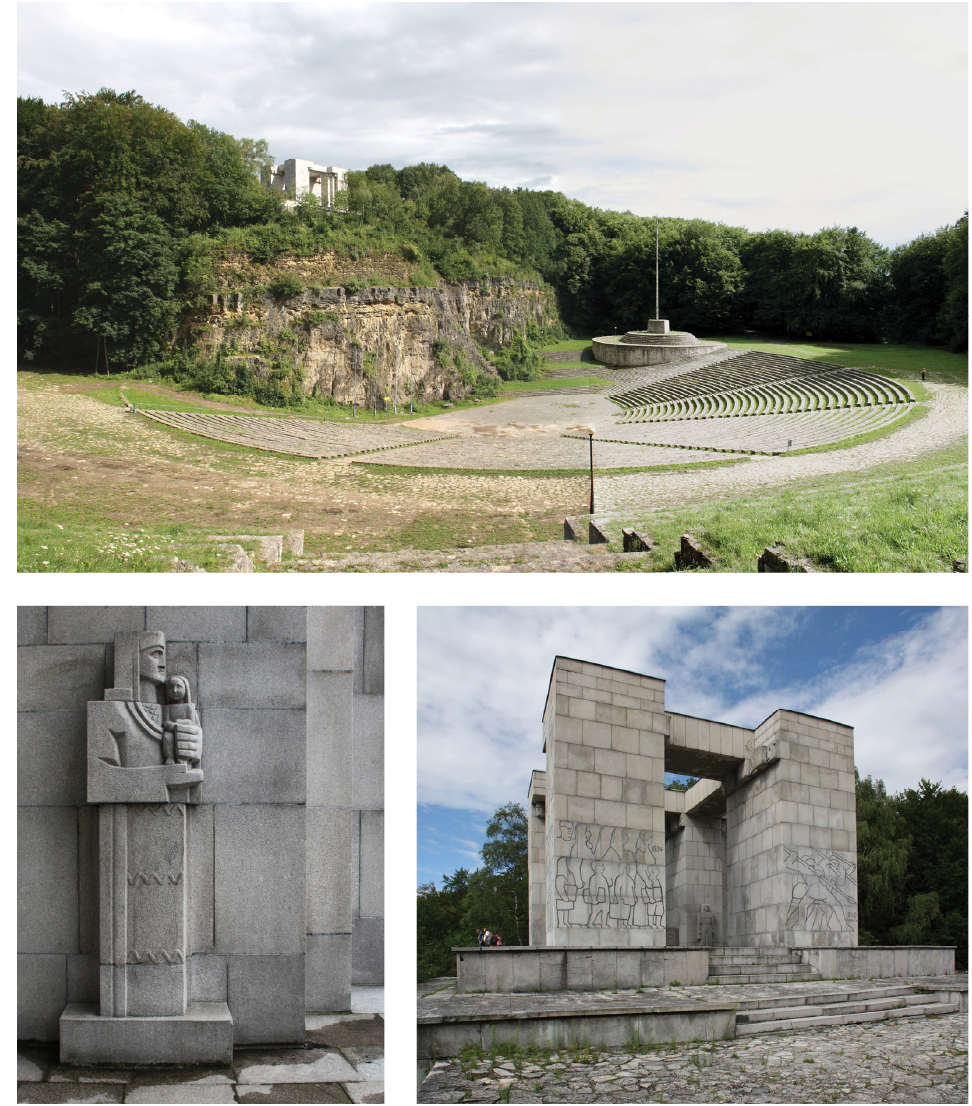
Figure 10. Saint Anne Mountain, the Monument of the Insurgents’ Deed today (photo 2019, created by authors).